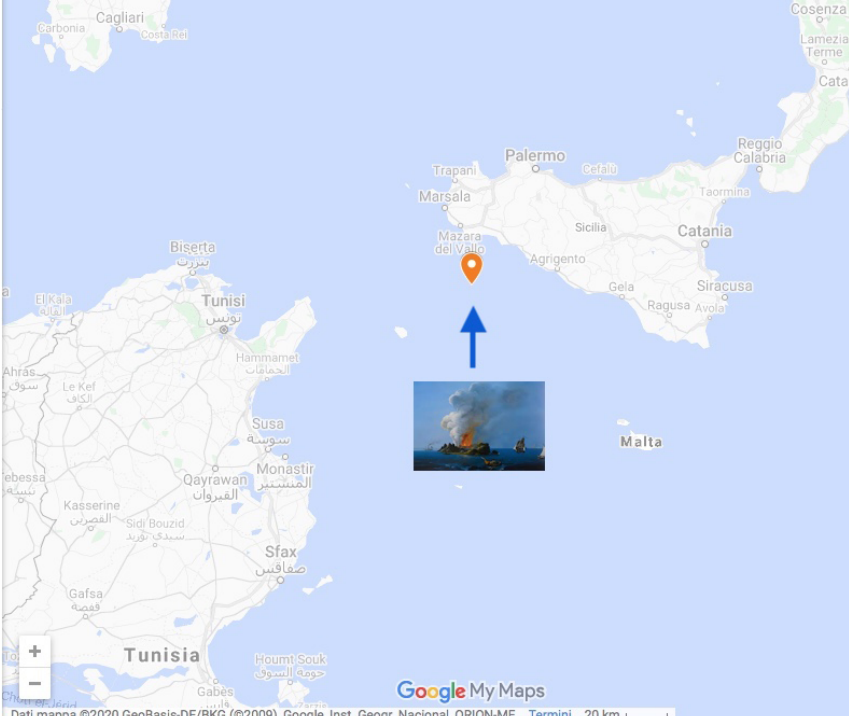
Figure 5. Location of the Ferdinandea island. The island is just 8m below sea level and about 50km from the shore. The map was generated by the author using Google maps. Figure 1 is shown in the inset. © 2020 Google